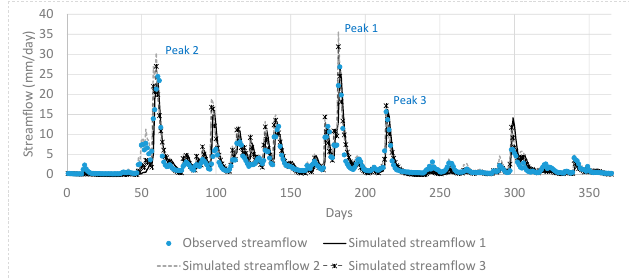
Figure 11. Observed and simulated hydrographs obtained by using three representative global Pareto solutions. The first has a percent bias (PB) of 3.04 × 10 − 8 % and three peak flow difference (TPFD) of 9.07 mm/day (simulated streamflow 1), the second has a PB of 29.71% and TPFD of 3.96 mm/day (simulated streamflow 2), and the third has a PB of 1.87% and TPFD of 8.35 mm/day (simulated streamflow 3).